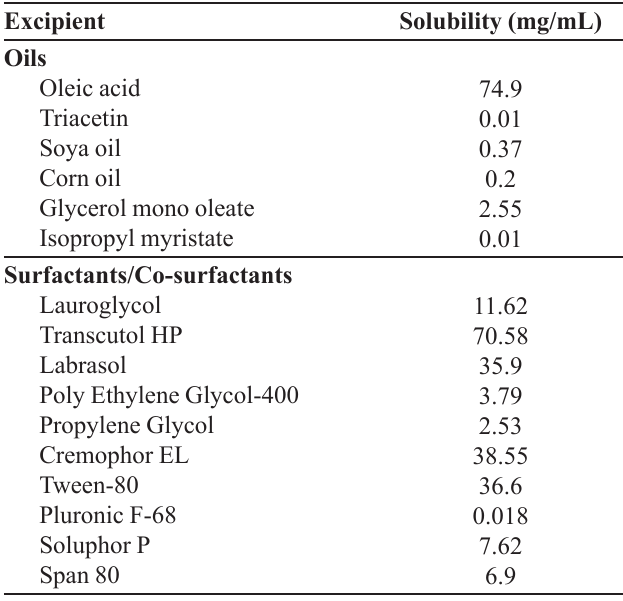
TABLE I - Solubility of domperidone in various